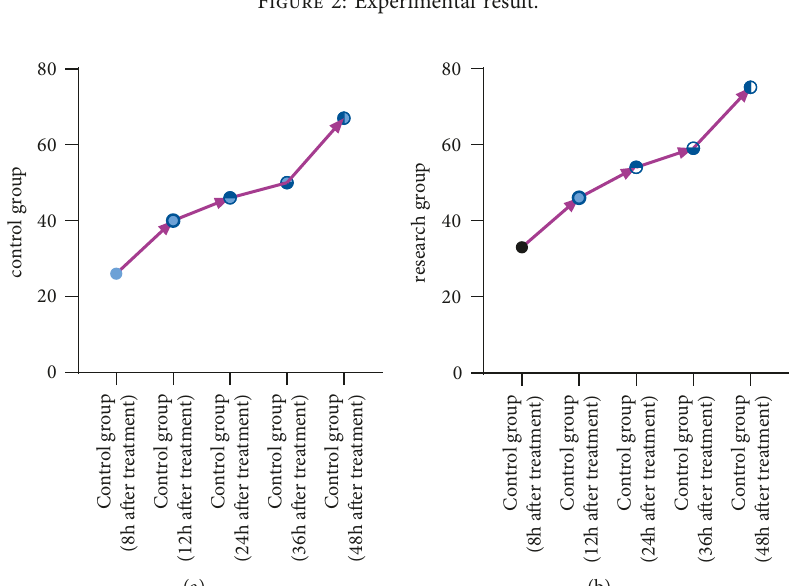
Figure 2: Experimental result.